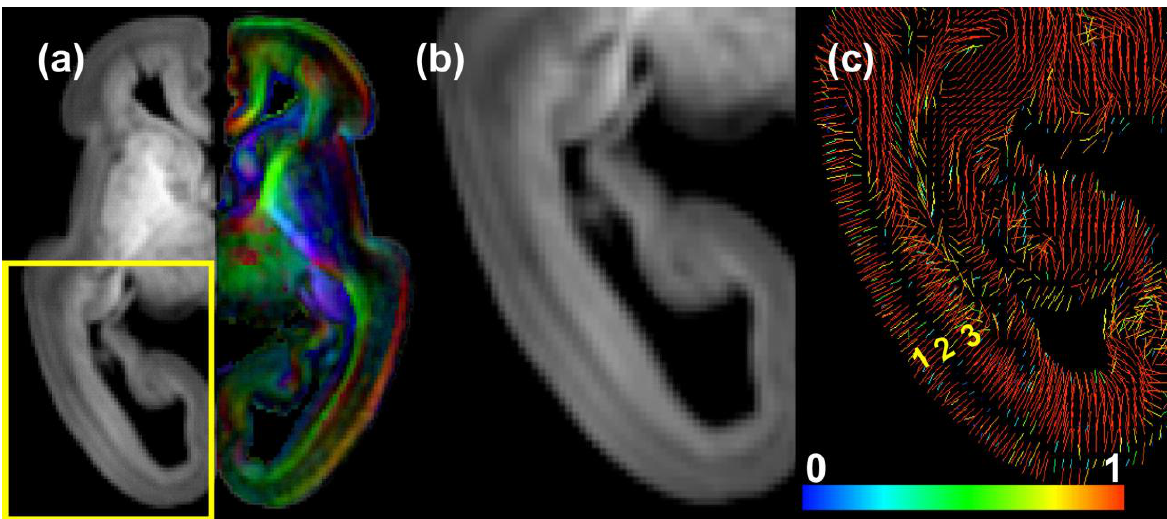
FIGURE 5. The axial averaged diffusion weighted image on the left and directionally encoded color map on the right of a 21-week brain are shown in (a). (b) is the enlarged yellow box in (a), showing the laminated layers in the cerebral wall and (c) is the visualization of the primary eigenvectors in the yellow box of (a). Three layers are labeled in (c) where primary eigenvectors of the diffusion tensor are oriented radially in layers 1 and 3. The black band between layers 1 and 3 in (c) is layer 2, where the primary eigenvectors are oriented in other direction, mostly perpendicular to the image slice. The color in (c) indicates the magnitude of the eigenvector projected to this axial plane, as illustrated by the color